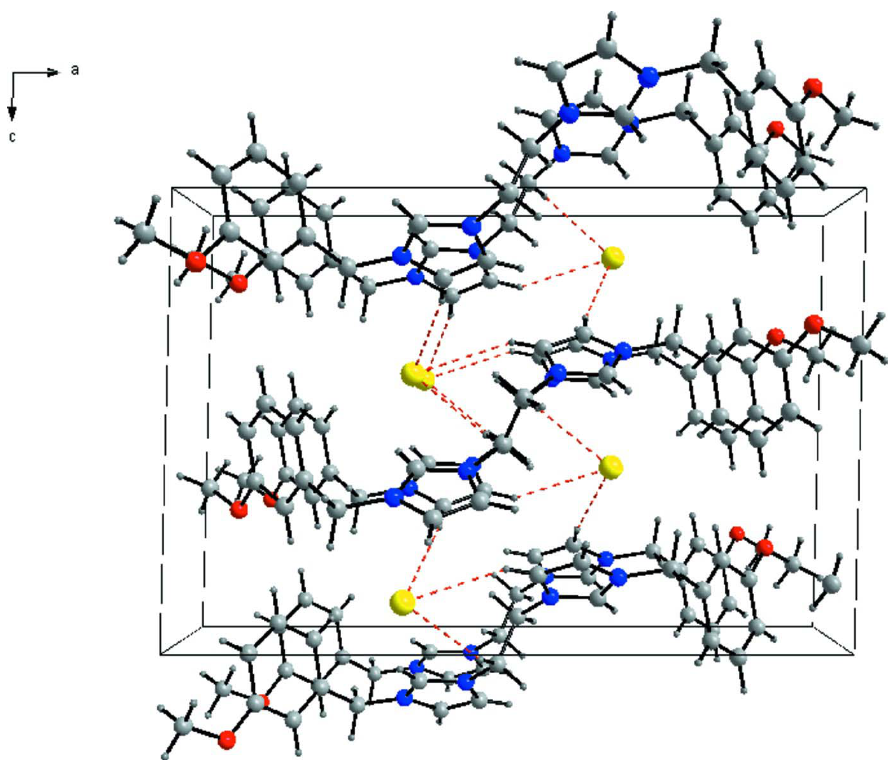
Figure 2 A view of the crystal packing along the b axis. Hydrogen bonds are shown as dashed lines. 3,3 ′ -Bis(3-methoxybenzyl)-1,1 ′ -ethylenediimidazolium